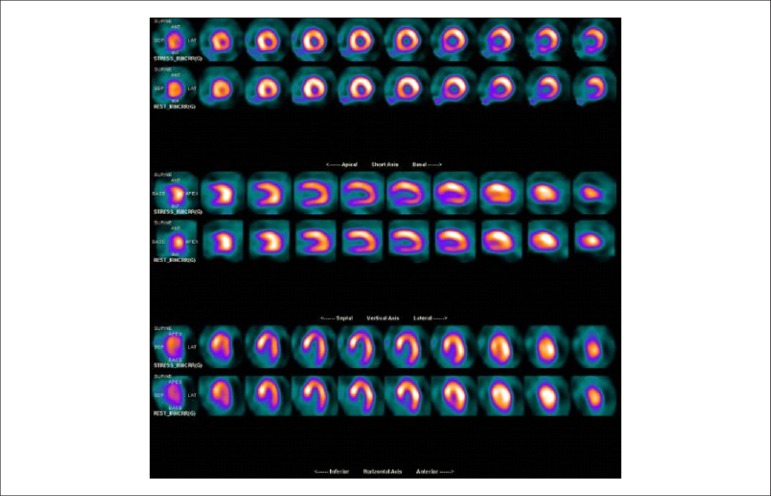
Case 3 - Myocardial perfusion scintigraphy showing mild alterations in myocardial perfusion, with analysis limited by significant obesity (grade III). Images acquired with dedicated cardiac equipment (gamma camera), equipped with conventional sodium iodide crystals.